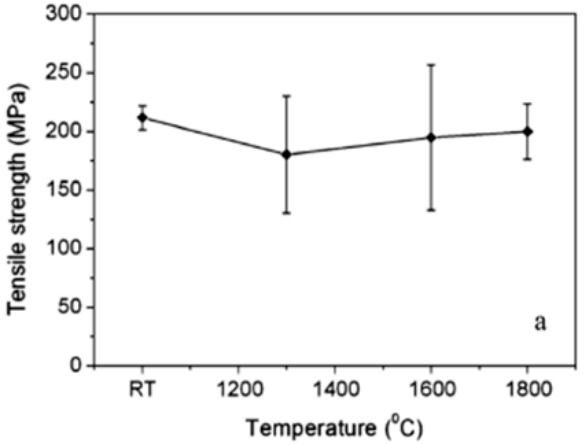
Table 2. The main components of C/SiC composite.